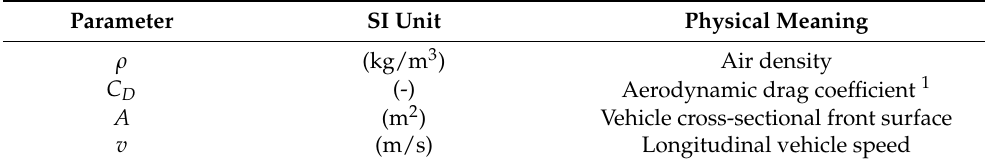
Table 2. Physical quantities involved in the aerodynamic drag resistance